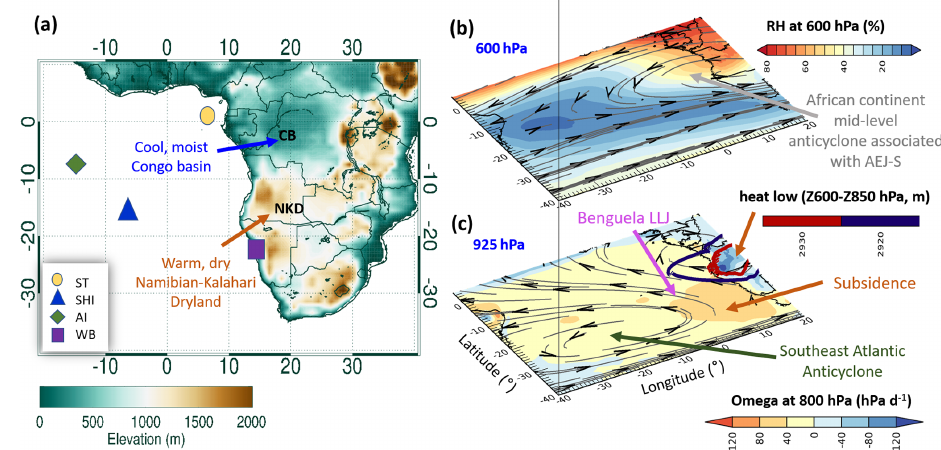
Figure 1. (a) Map of the ORACLES deployment region in the SE Atlantic and elevation of southwestern Africa. The markers represent São Tomé (ST), St. Helena island (SHI), Ascension Island (AI), and Walvis Bay (WB). (b) The 600hPa climatological September monthly mean (2000–2018) RH (color shading; percent), overlain by horizontal wind streamlines (meters per second; hereafter ms − 1 ). (c) The 800hPa climatological September mean (2000–2018) vertical velocity (omega at 800hPa; positive values represent subsidence in hectopascals per day; hereafter hPad − 1 ) overlain by 925hPa horizontal wind streamlines with the thickness between 600 and 850hPa (heat low and contours in dark red and navy; meters).